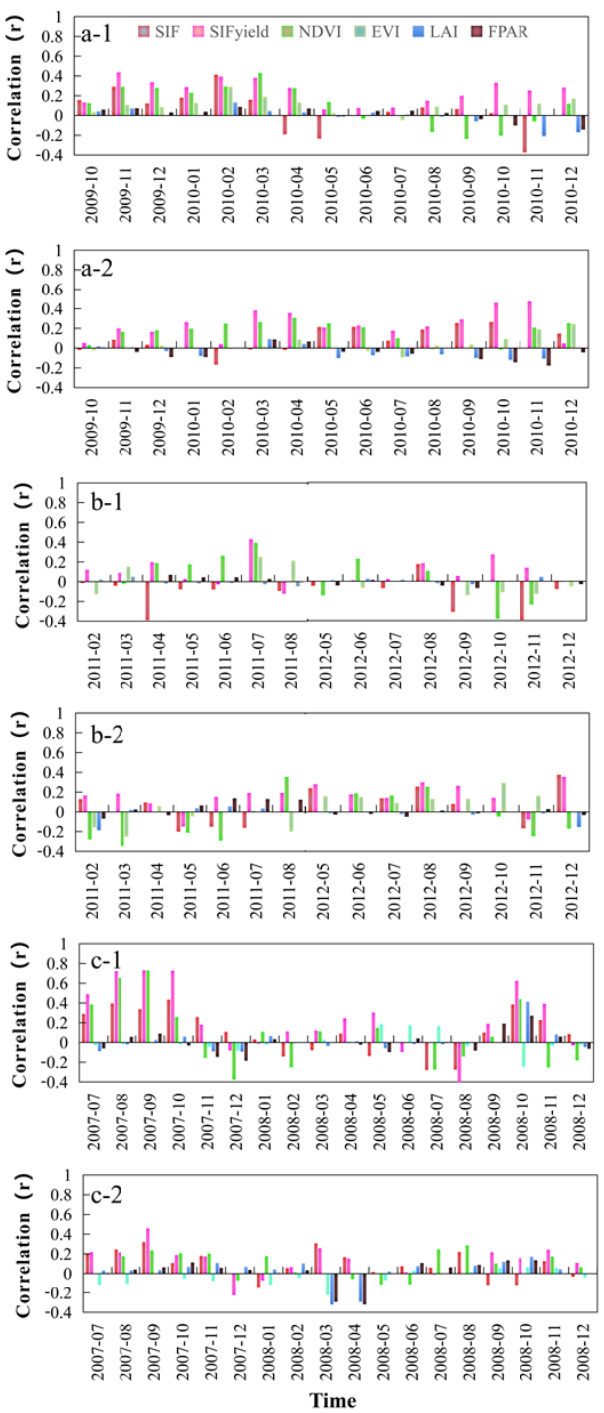
Figure A4. Correlation between standardized anomalies of SIF, SIFyield, NDVI, EVI, LAI, and fPAR with SPEI. ( a-1 ) the subtropical evergreen broad-leaved forest region in Yunnan province; ( a-2 ) the tropical monsoon rainforest and rainforest region in Yunnan province; ( b-1 ) the subtropical evergreen broad-leaved forest region in Shaanxi province; ( b-2 ) the warm-temperate deciduous broad-leaved forest region in Shaanxi province; ( c-1 ) the cold-temperate coniferous forest region in Heilongjiang province; ( c-2 ) and the temperate coniferous and deciduous broad-leaved mixed forest region in Heilongjiang province.